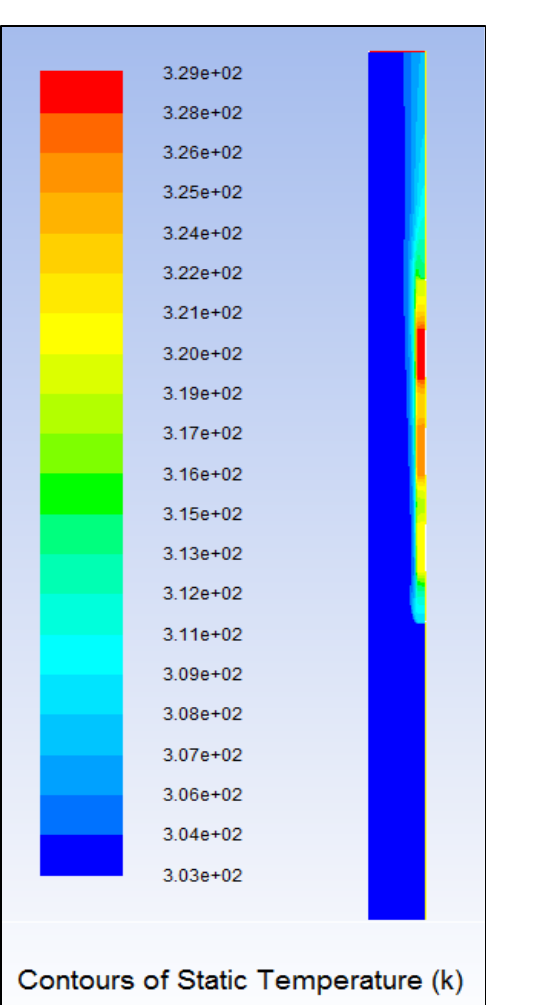
Figure 4. Temperature contours for discrete heat sources on vertical channel